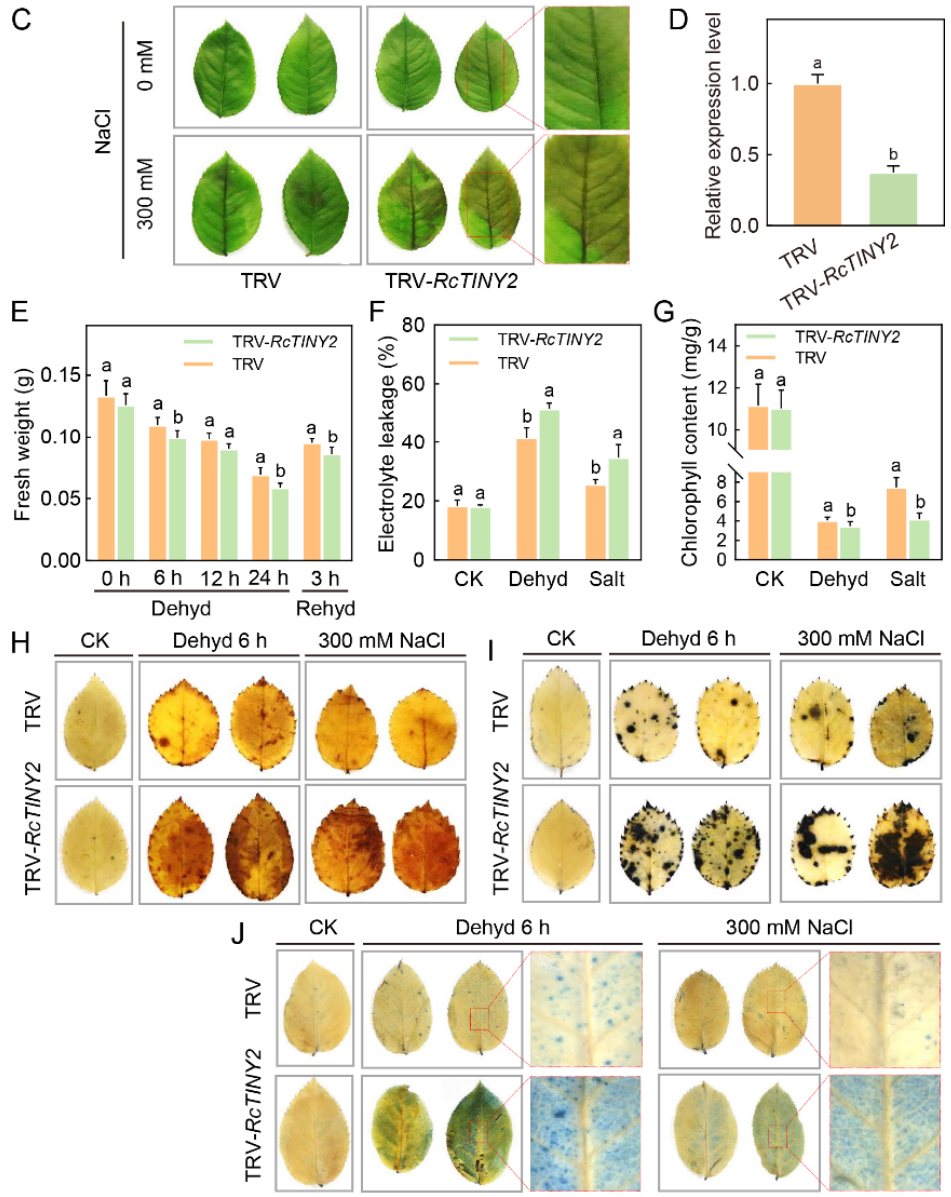
Figure 6. Decreased dehydration and salt stress in RcTINY2 -silenced rose leaves. ( A ) Phenotypes of TRV and TRV- RcTINY2 leaves after dehydration and rehydration; ( B ) Relative expression levels of RcTINY2 in TRV and TRV- RcTINY2 under dehydration stress; ( C ) Phenotypes of TRV and TRV- RcTINY2 leaves under salinity stress; ( D ) Relative expression levels of RcTINY2 in TRV and TRV- RcTINY2 under salinity stress; ( E ) Fresh weight of TRV and TRV- RcTINY2 leaves after dehydration and rehydration; ( F ) Electrolytic leakage and ( G ) chlorophyll content of TRV and TRV- RcTINY2 leaves under dehydration and salt stress; All data are the mean ± SD for three biological replicates. LSD tests were used to determine statistically significant differences ( p < 0.05) which are indicated by different letters. ( H ) DAB, ( I ) NBT, and ( J ) trypan blue staining of TRV and TRV- RcTINY2 leaves under dehydration and salt